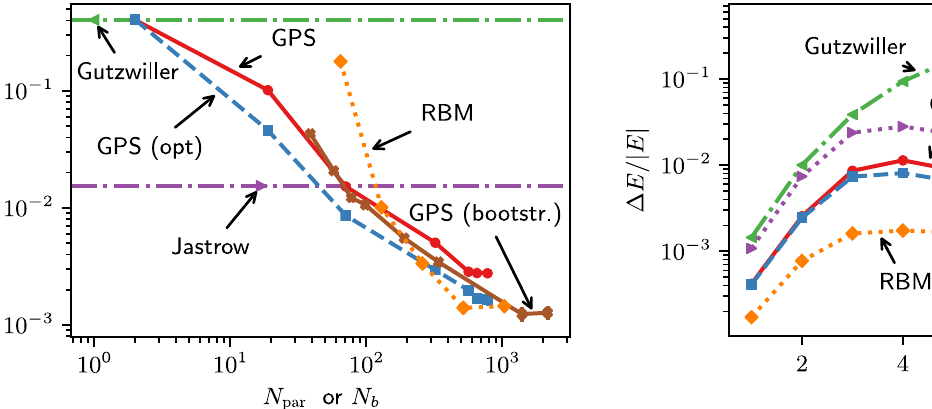
FIG. 4. Relative energy errors for the half-filled Hubbard chain FIG. 5. Relative energy error (compared to DMRG) against (compared to DMRG) at U ¼ 8 t , L ¼ 32 , as a function of the size U=t for GPS, Gutzwiller, Jastrow, and RBM states, for a half- of the chosen set of configurations ( N ), as the kernel complexity filled 32-site Hubbard chain. The GPS ansatz is obtained from a b p is increased from 0 to 6 ( θ ¼ 0 ; L 0 ¼ 6 ). For other methods, fit on a 12-site chain solution with training configurations coming N denotes the number of variational parameters optimized in from an L 0 ¼ 6 lattice with all possible particle and spin par fluctuations using kernel hyperparameters ( p ¼ 4 , θ ¼ 0 ). All the state, as a measure of compactness and variational freedom of ansatze are built on the same fixed free-fermion orbitals. the state. The GPS is trained on the features of the ground state of Monte Carlo optimizations for the Gutzwiller, Jastrow, and a small 12-site lattice using configurations with all particle and RBM (with α ¼ 5 ) states are performed for 10 seeds, with the spin fluctuations from an L 0 ¼ 6 lattice. Subsequent variational variationally lowest result shown. The red curve shows the GPS optimization of the training weights of the GPS gives rise to the “ GPS (opt) ” values. For comparison, variationally optimized and result, with the weights solely obtained from the fit on the fragment amplitudes; the blue curve represents additional varia- tional optimization of the weights, with the L 0 ¼ 6 data set included, with the RBM ratio of hidden to visible nodes ( α ) chosen as 1, 2, 4, 8, and 16 [23], taking the best result of 10